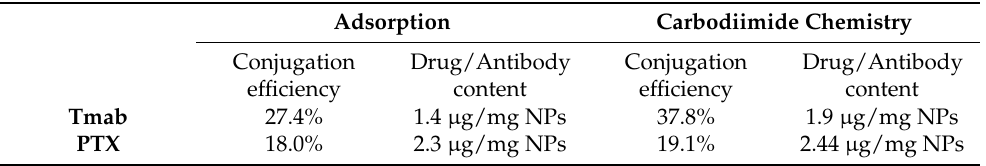
Table 1. Conjugation efficiencies (%) and Tmab (Trastuzumab) and PTX (Paclitaxel) content in PDA NPs ( µ g/mg) after adsorbing the drug and loading the antibody by adsorption or by means of the carbodiimide